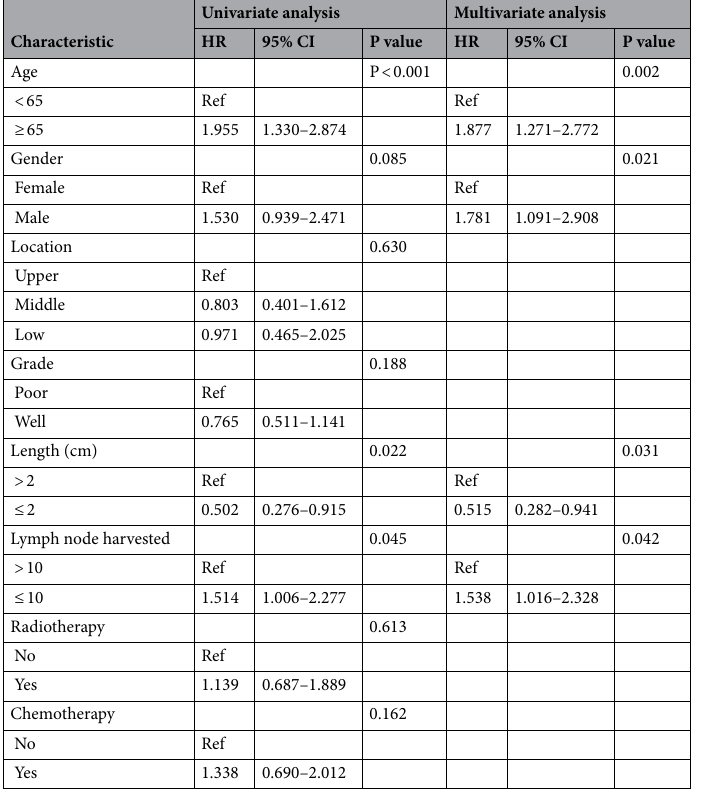
Table 2. Univariate and multivariate Cox proportional hazard model analysis in the training